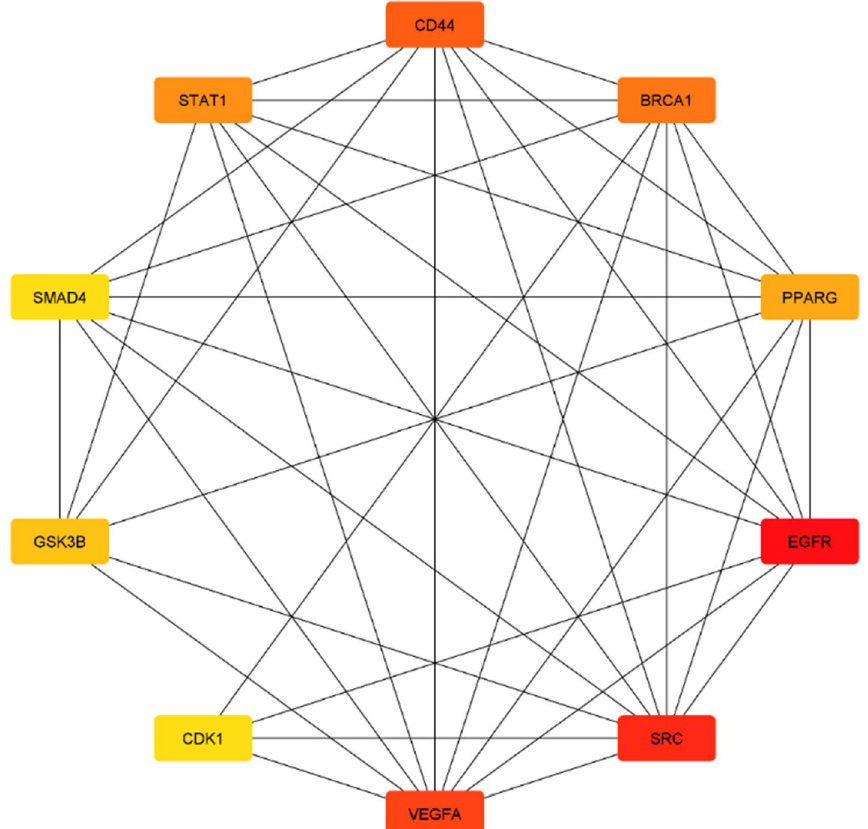
Fig. 2 The top 10 interacting targets of the PPI network were retrieved using the CytoHuba plug-in of Cytoscape. The colour represents their degrees of interactions in the initial PPI network, with red representing the top most interacting gene; orange representing the medium most interacting genes; and yellow representing the sparsely interacting